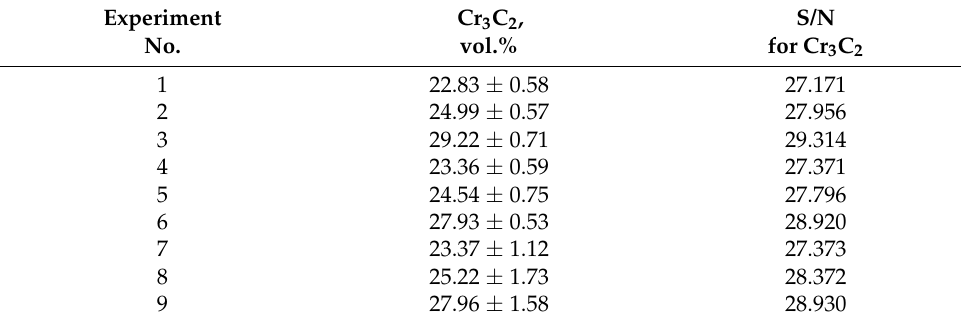
Table 3. Results of the Taguchi experiment for Cr 3 C 2